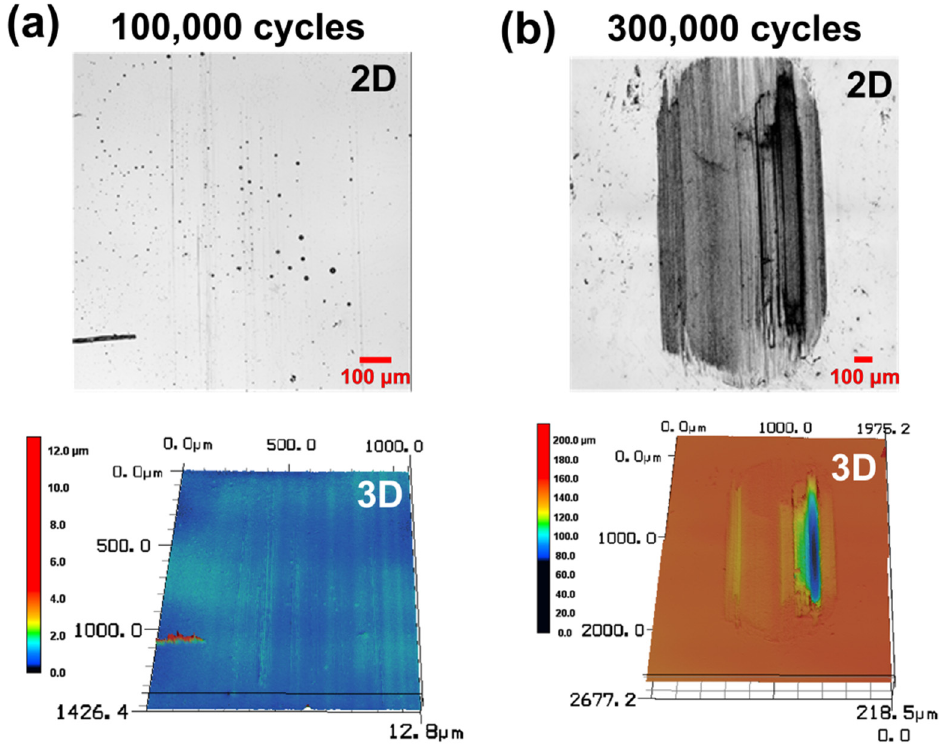
Figure 7. Confocal microscope 2D/3D profile images of wear track of PDMS specimen under 500 mN normal load and 1 wt % surfactant–water lubricated condition after ( a ) 100,000 and ( b ) 300,000 cycles.